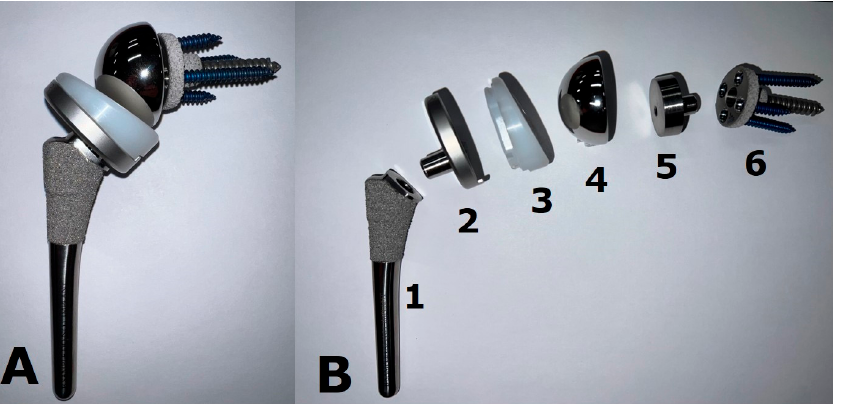
Figure 3. Example of a reverse total shoulder arthroplasty (RTSA) implant. This prosthesis is shown ( A ) assembled and ( B ) deconstructed. The stem (1) is porous-coated proximally to allow for biologic osseous integration. The humeral tray (2) is fixed to the stem via a Morse-tapered trunnion and articulates via a polyethylene liner (3). The glenoid base plate/metaglene (6) is porous-coated as well to facilitate osseous integration. It is fixed via a central screw that provides compression and is reinforced with locking screws peripherally. The glenosphere (4) attaches to the glenoid baseplate/metaglene via an eccentric Morse taper (5) to allow for distalization of the components and minimize scapular notching.